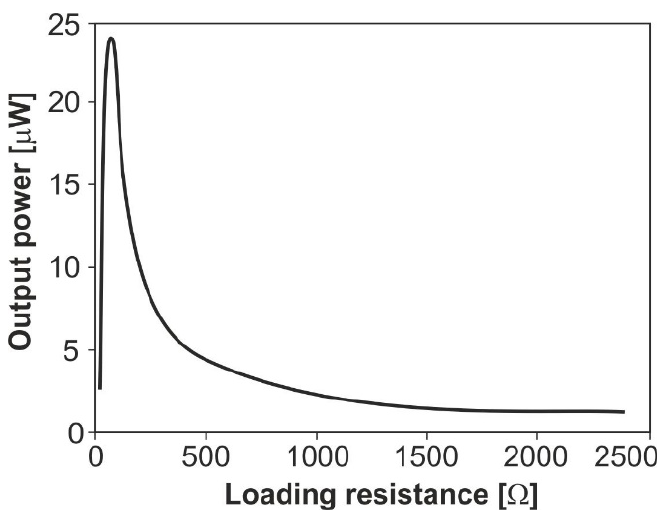
Figure 6. Output power generated by the energy harvester as a function of loading resistance, result for optimal geometry of the 3D-printed microstructure (Table 1). Table 1. Main paramaters of the simulated and 3D-printed MEMS-type electromagnetic energy harvesters. Visualisation of the Harvester Structure and Number of